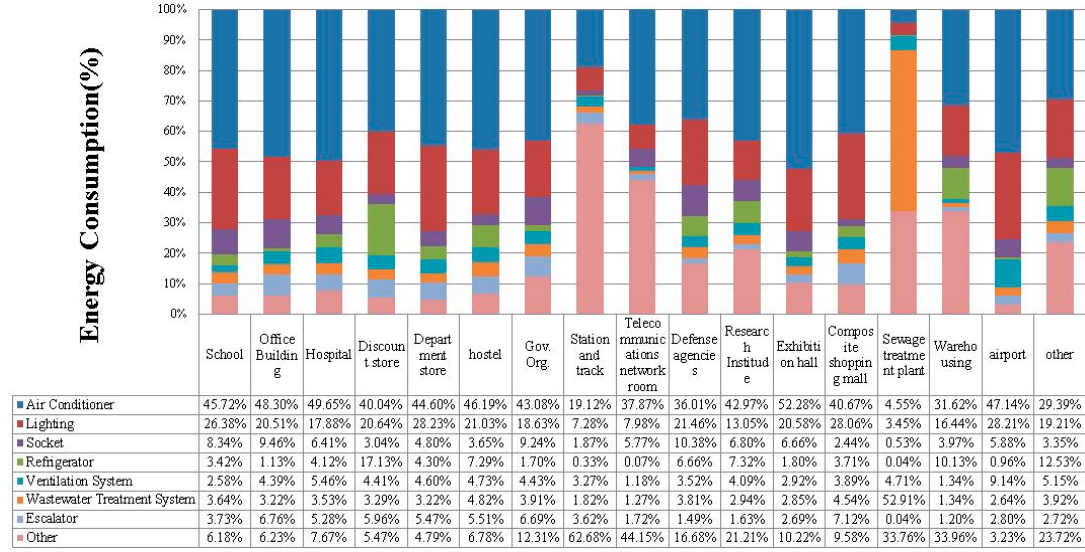
Figure 1. Analysis of the proportion of energy consumed in various types of buildings in Taiwan [1].